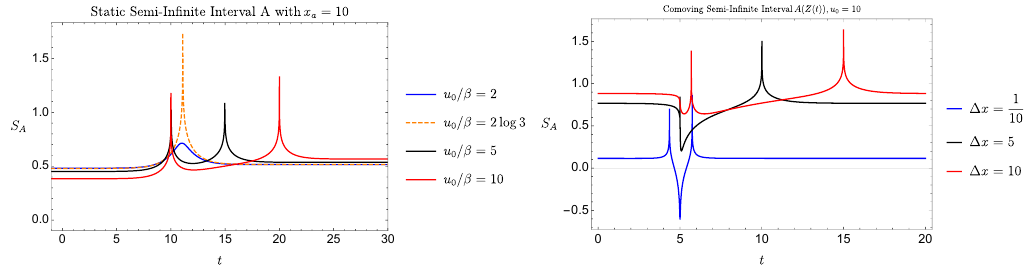
= 10 . Right: co-moving, semi-infinite a